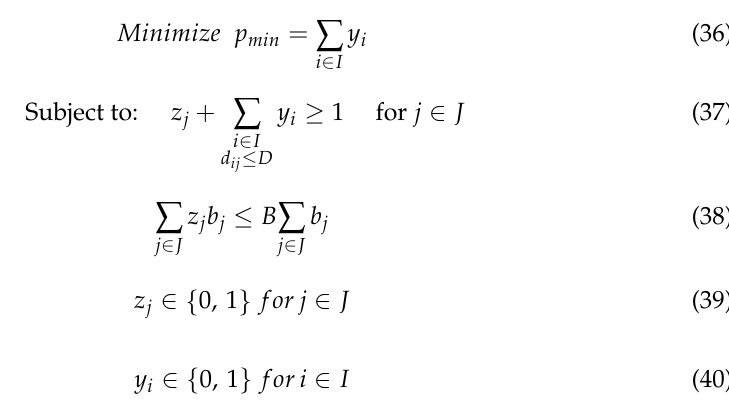
Figure 4. Districts of the autonomous region of Žilina. The region of Žilina is formed by 315 network nodes, which correspond to individual cities, villages, and small communities. For simplicity, we assume that each network node offers at least one possible location for establishing a fire station. Otherwise, the set of candidates would be necessary to redefine. Obviously, all inhabited nodes represent pos- sible demand points in which an emergency may occur. Thus, sets I and J are the same. The weight coefficients b j are set according to the number of inhabitants, and they are rounded up to hundreds since more precise data for fire brigade deployment (degree of fire risk, number of emergency calls, etc.) are currently not available. Let us now focus on the fire brigade system in Žilina. The fire brigade system in the self-governing region of Žilina currently operates 15 stations, which are deployed in Bytča, including Čadca, Dolný Kubín, Kysucké Nové Mesto, Liptovský Hrádok, Liptovský Mikuláš, Martin, Námestovo, Rajec, Ružomberok., Terchová, Turčianske Teplice, Turzovka, Tvrdošín, and Žilina. The average distance be- tween served network nodes and their nearest located fire station is 5.37, but the maximal relevant distance from a user’s location to the nearest FPU is already 33. This fact confirms that there is at least one dwelling place or a small community that is too far from any service provider. As we can see, the longest distance exceeds the average value multiple times. Just for interest, the number of residents whose distance exceeds the value of 10 is 1407 (this number is given in 100s), which represents more than 20 percent of the served population. Obviously, such a simple analysis confirms the necessity of system optimiza- tion. Therefore, we performed some numerical experiments with the basic models.